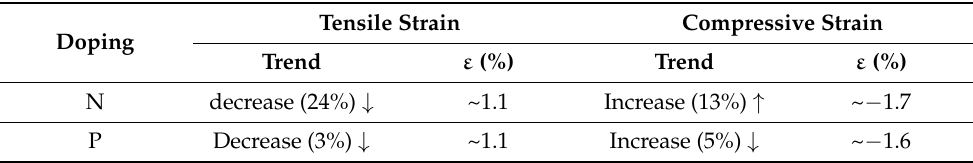
Table 4. Trends of the Seebeck coefficient for n-and p-type µ c-Si: H showing the maximum strain applied during the